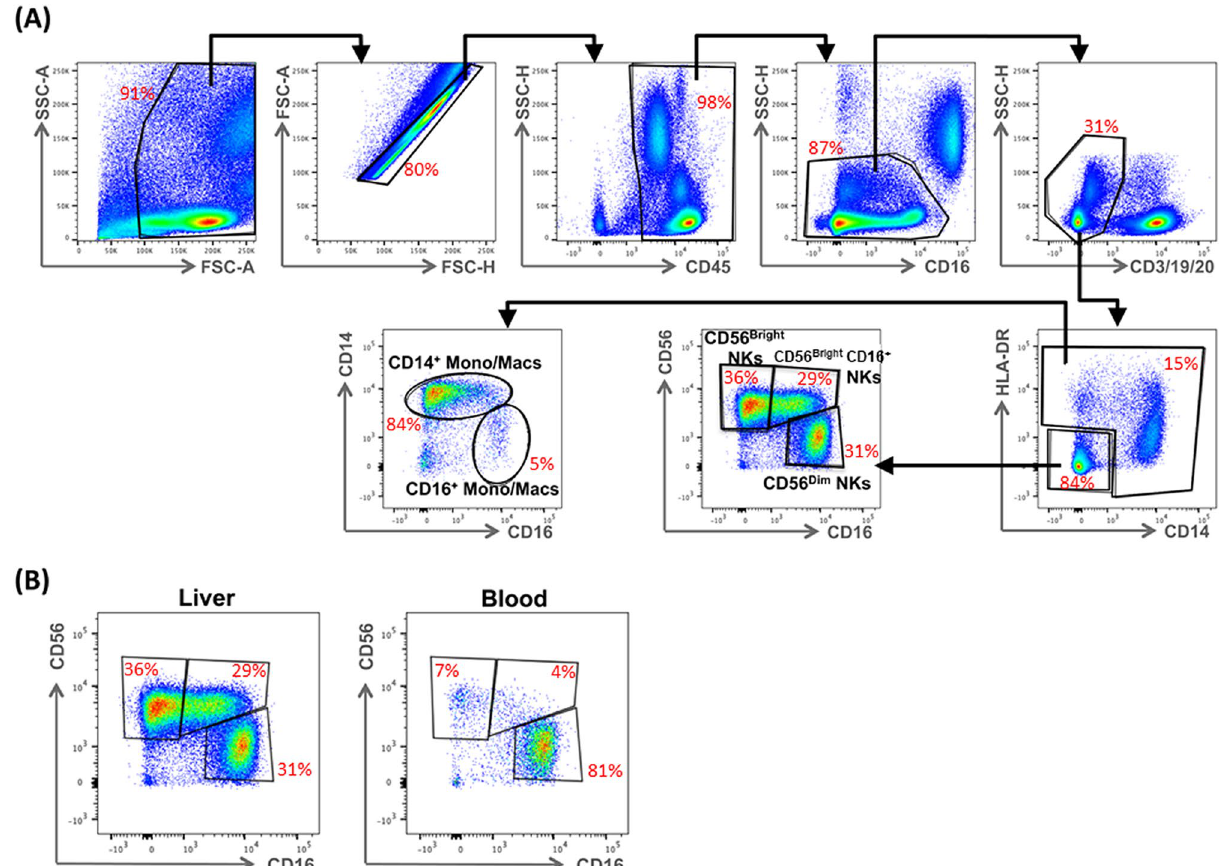
Figure 1. Identification of hepatic innate immune cell populations by multiparameter flow cytometry, the gating strategy. (A) Hepatic mononuclear cells from a representative liver were stained with a nine-color antibody panel: CD45, CD3, CD19, CD20, HLA-DR, CD14, CD16, CD123, BDCA1, BDCA3, and CD56. Innate immune mononuclear cells were selected based on viability (live/dead), unicellularity (singlets), CD45 expression (CD45 + ), intracellular complexity (non-granulocytes/granulocytes), and lack of expression of lineage markers (CD3 - , CD19 - , CD20 - ). (B) Difference in expression of CD16 + NK cells in liver compared to blood for a representative